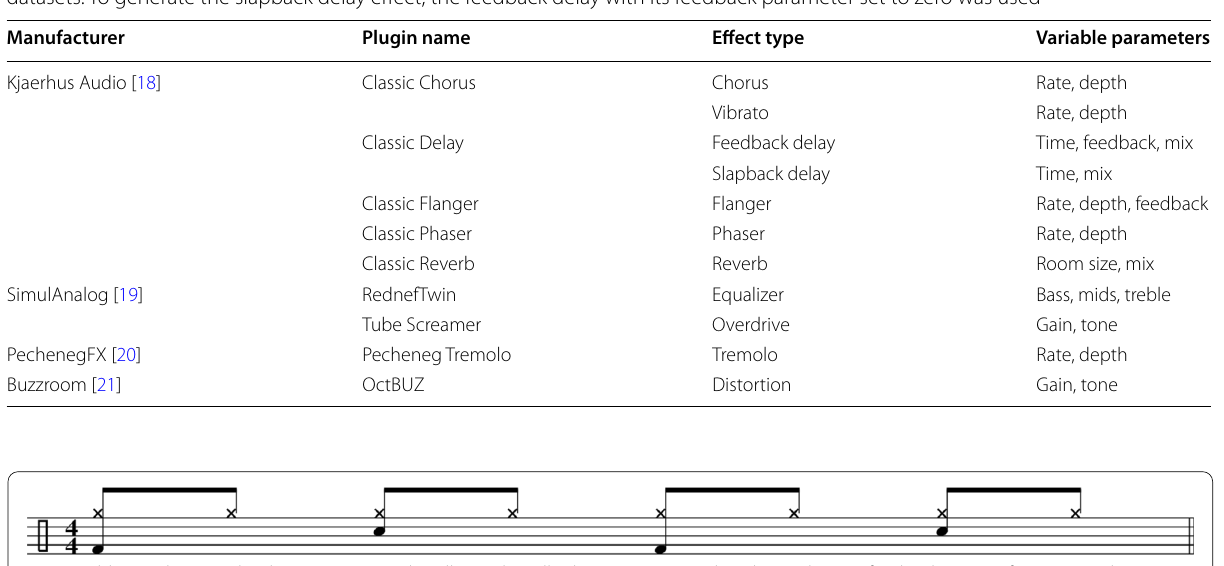
Fig. 1 Tablature showing the drum pattern used in all samples. All other instruments played a single note for the duration of 2 s, i.e., one